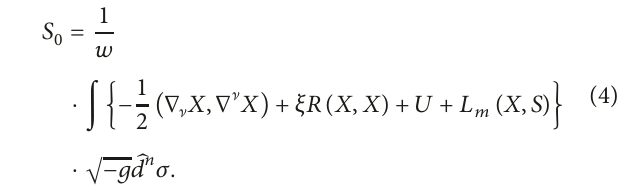
graph and 4.5 percent of measurement errors are attributed to the local fluctuations